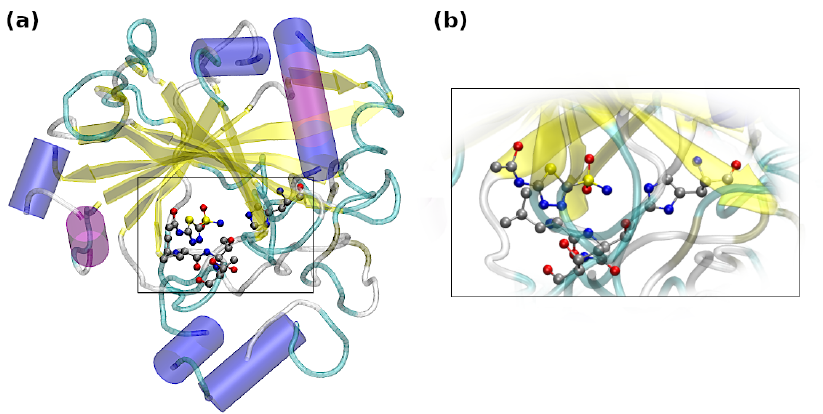
Figure 1. Visualization of the ( a ) ligand and the Carbonic Anhydrase IX mimic and ( b ) the magnified binding site of the Carbonic Anhydrase IX mimic. Cartoon representation was chosen for the protein, whereas the investigated amino acids and ligand were presented with usage of a ball-and-stick model, color coding: silver—carbon, yellow—sulfur, blue—nitrogen, red—oxygen.